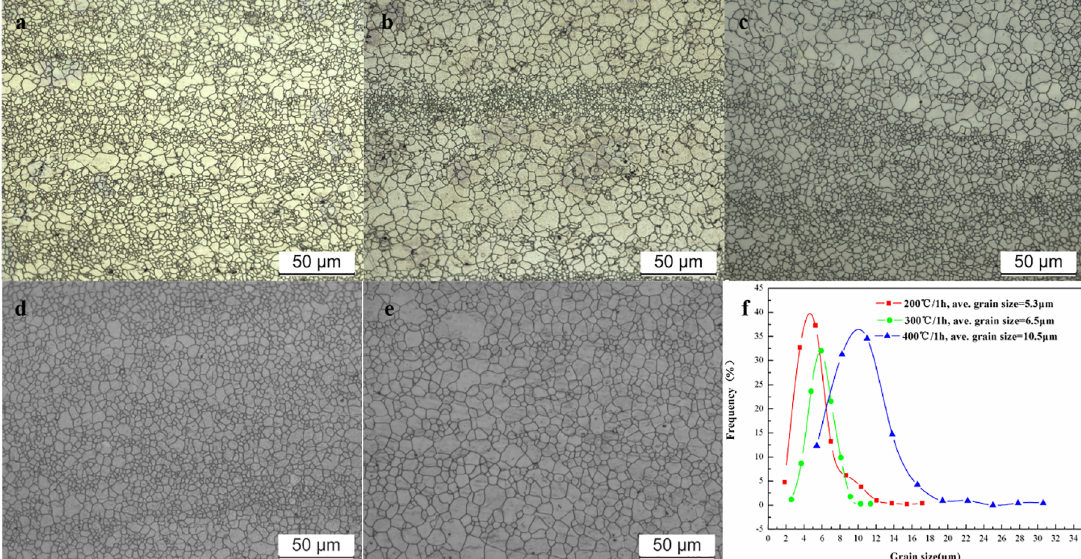
Figure 7. Microstructure of the Mg alloys of composite plates at different conditions: (a) near the interface of rolled sample without annealing, (b) far away from the bonding interface of rolled sample without annealing, (c) 200°C / 1 h, (d) 300°C / 1 h, (e) 400°C / 1 h and (f) Grain size distribution from (c to e).